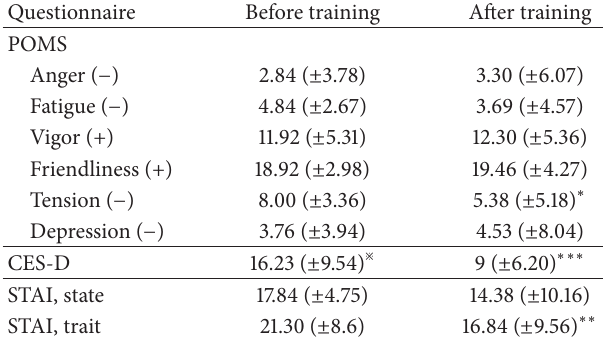
Table 2: Profile of Mood States (POMS), Center for Epidemio- logic Studies Depression Scale (CES-D), and State-Trait Anxiety Inventory (STAI) scores before and after meditation training. Group means and standard deviations are listed. Significant group differences are listed as follows: ∗∗∗ : significant at 𝑝 < 0.001 , ∗∗ : significant at 𝑝 < 0.01 , and ∗ : significant at 𝑝 < 0.05 . n : before training, 6 out of 13 subjects surpassed the cutoff for depression. (+): positive mood state factor, ( − ): negative mood state